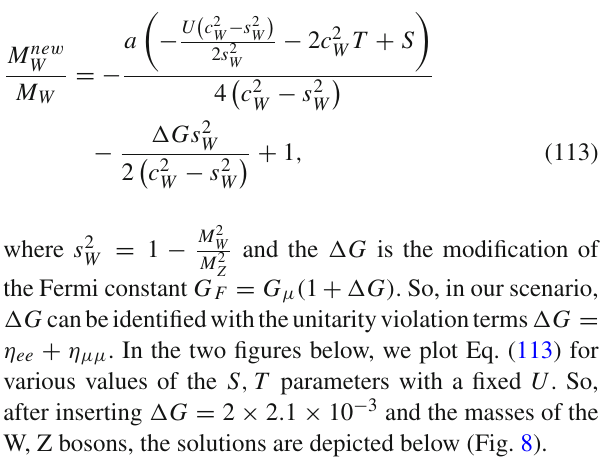
Fig. 7 Plot of case (β) η (112) (black dots under the assumption η ee ∼ = 174 GeV, M ν c = 4 . 3 × 10 14 GeV, M η μμ ),using m ν D M ν c s = 89 . 3 × 10 3 GeV. Blue shaded region is the previous W-boson mass and green is the current